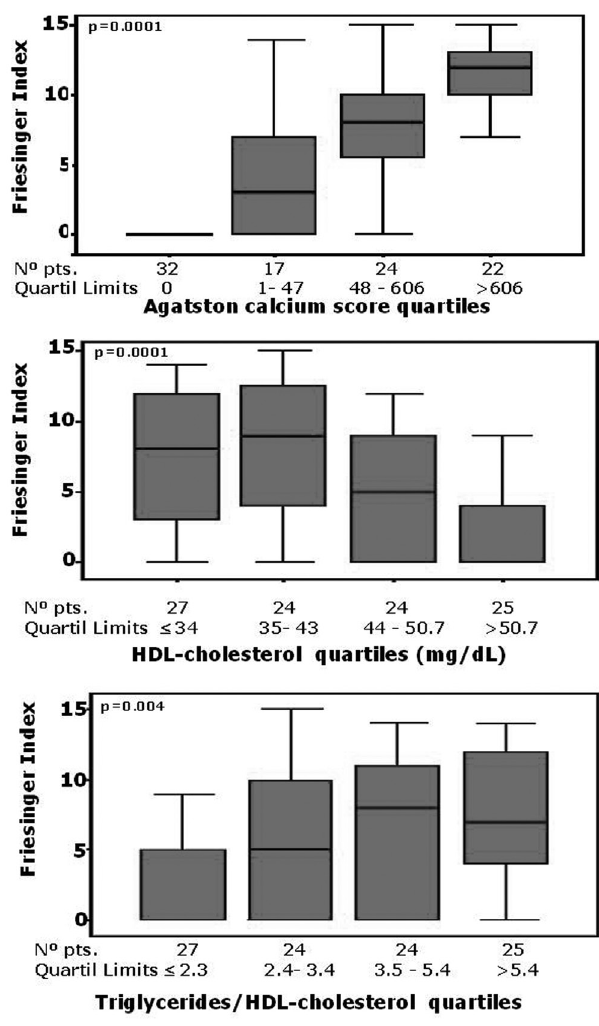
Figure 1 - Friesinger index boxplot distribution by Agatston quartiles, HDL-c quartiles and TG/HDL-c